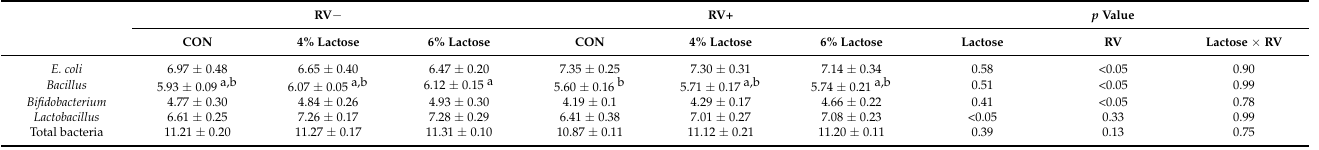
Table 11. Effect of dietary lactose supplementation and/or RV challenge on the number of some bacteria in the cecal digesta of weaned pigs (lg(copies/g)) 1 .